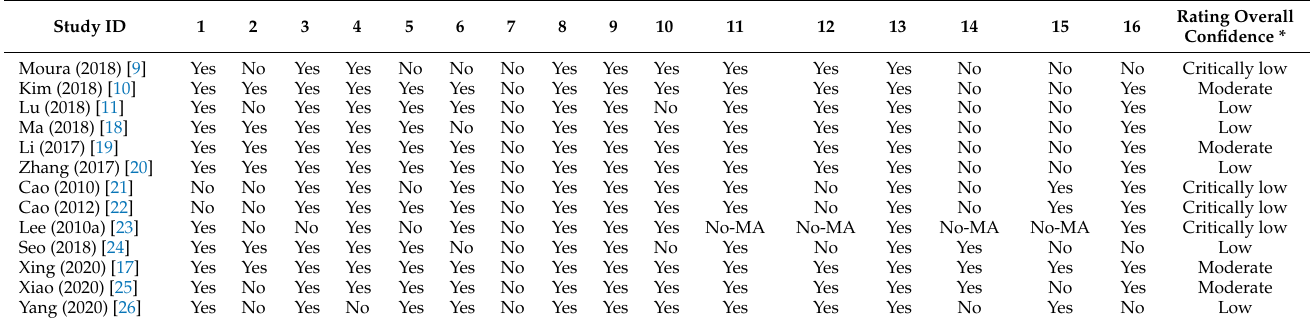
Table 2. Quality assessment of all included systematic reviews using AMSTAR